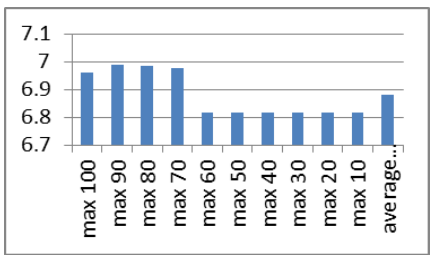
Figure 17. Maximal odontometric parameters at different various rates on a premolar.